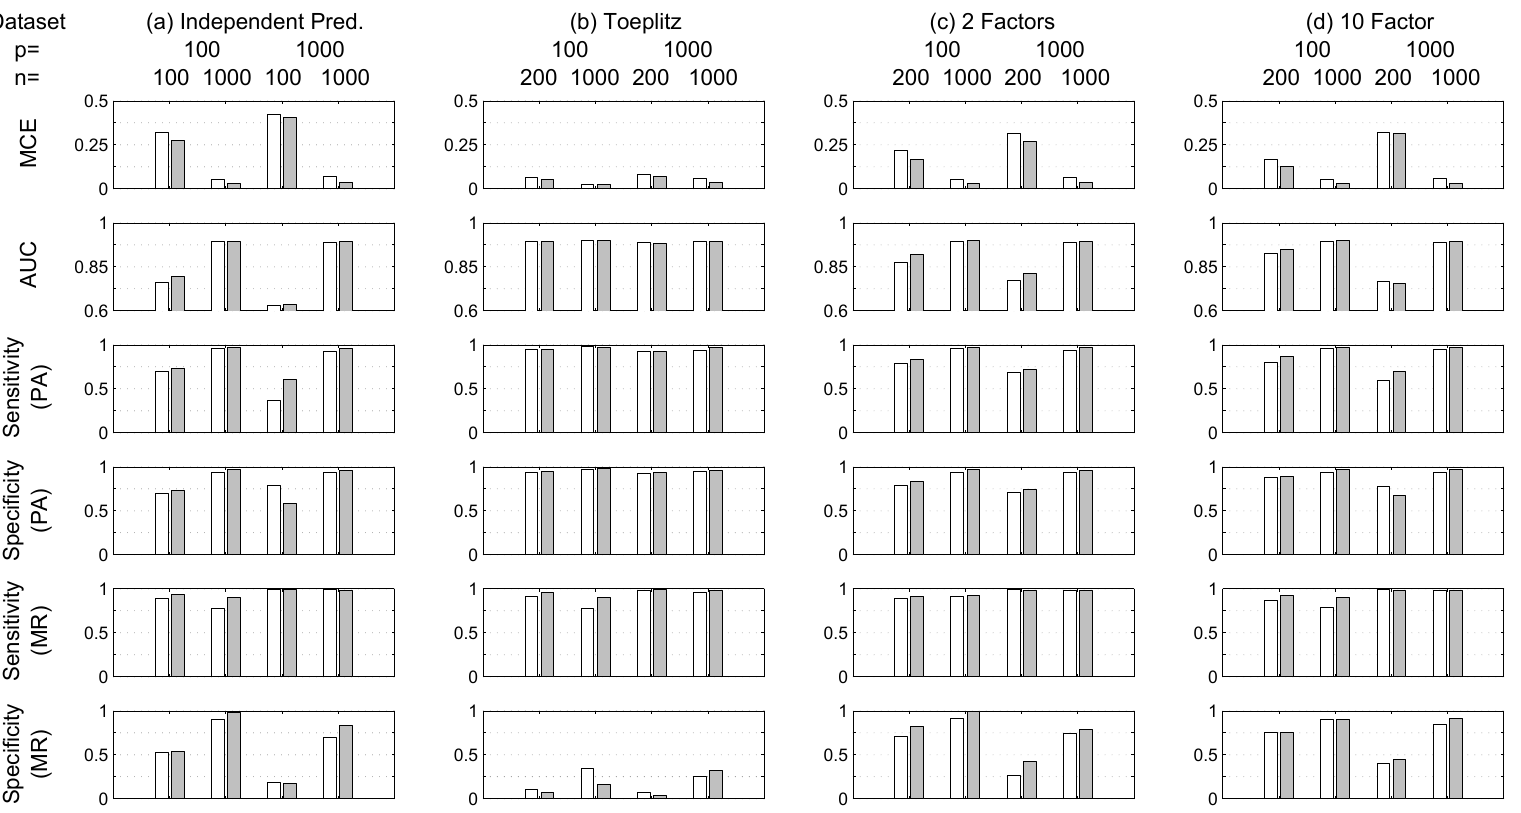
Figure 3. Summary of the simulation results obtained with simulated datasets ( a – d ): LASSO results; RVM